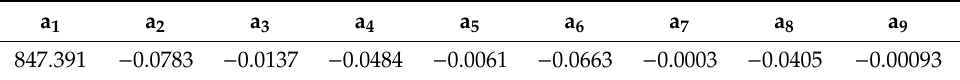
Table 8. Function parameters (1) approximating the results of plasticometric tests for TRIP steel. a